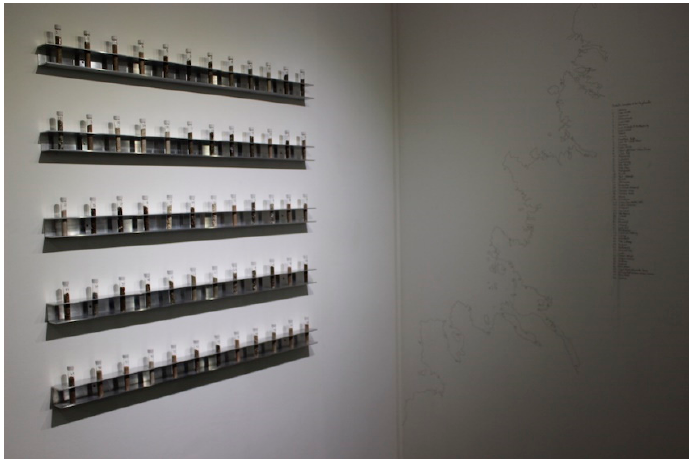
Figure 6. Sample, installation at Neo Terra exhibition, An Talla Solais, Ullapool. 13 May–18 June 2017. Photograph created by the author.